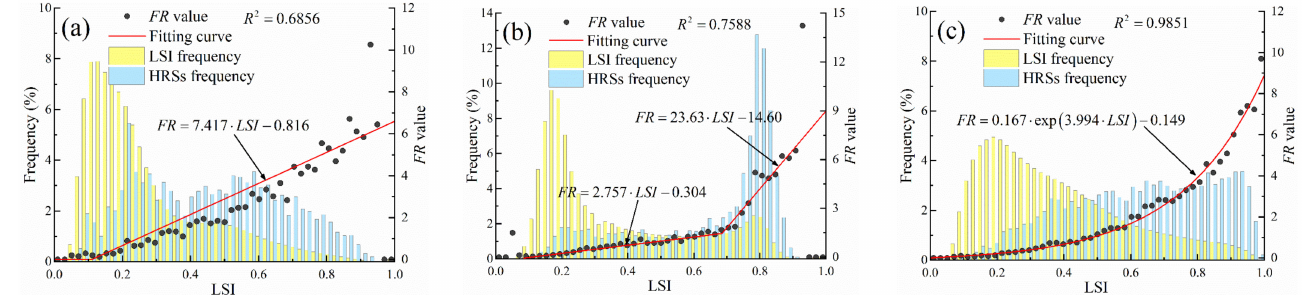
Figure 6. The relationship between the LSI and frequency ration value (landslide spatial probability): ( a ) LR model, ( b ) SVM model, and ( c ) ANN